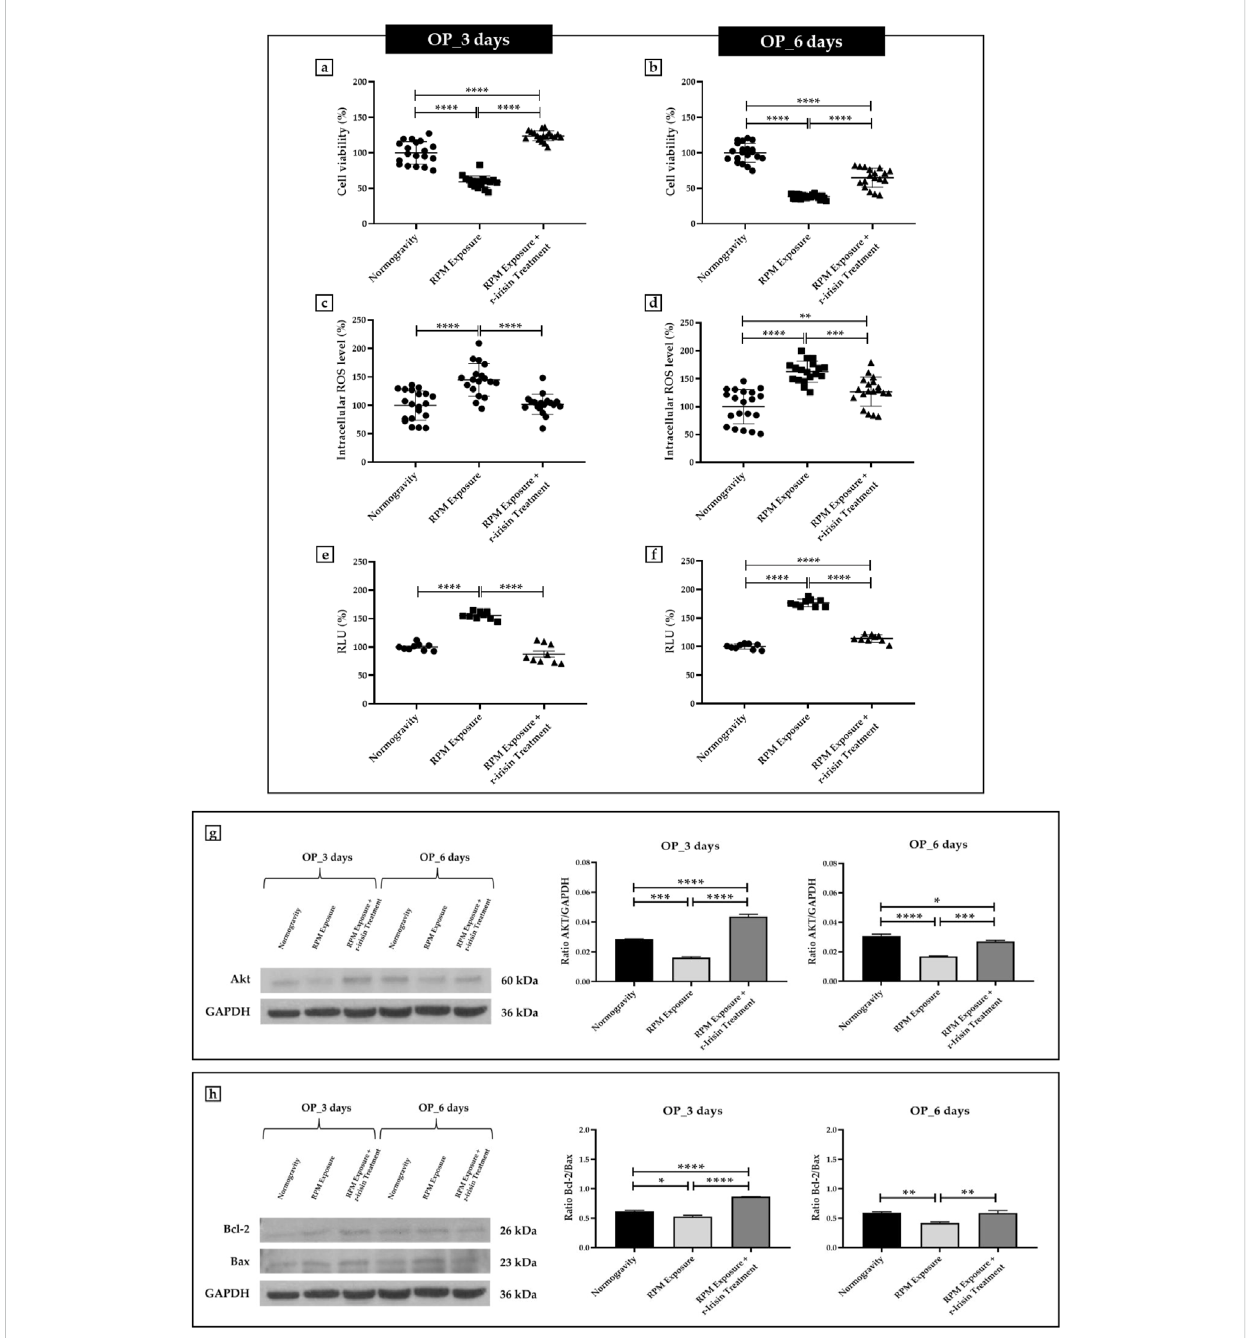
FIGURE 2 Effects of random positioning machine (RPM) exposure on the survival of primary osteoblast cultures derived from osteoporotic (OP) patients. (a,b) MTS assay: cell viability was completely (a) or partially (b) preserved in cells treated with r-irisin and exposed to RPM. (c,d) Intracellular levels of reactive oxygen species (ROS): the increase in oxidative stress induced by exposure to RPM was completely (c) or partially (d) counteracted by r-irisin treatment. (e,f) Caspase-3/7 activity: total (e) or partial (f) prevention of caspase activity induced by RPM exposure in r-irisin-treated cells. (g) Western blotting analysisforAkt/proteinkinaseB(PKB):r-irisintreatmentcompletely(3 days)orpartially(6 days)preservedAktexpression. (h) Westernblottinganalysisfor B-celllymphoma2(Bcl-2)and Bax:signi fi cantincreaseinBcl-2/Bax ratioafterr-irisin treatment(3 days);restoration ofbasallevels